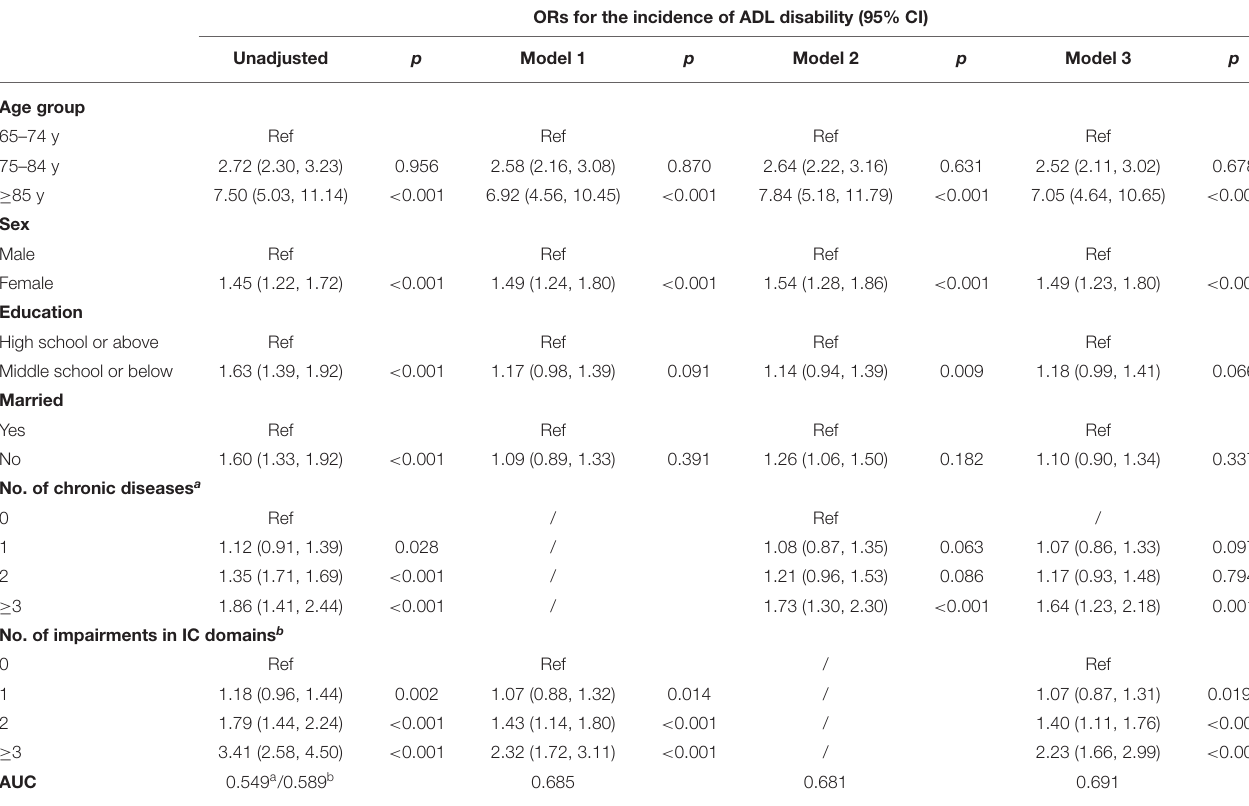
TABLE 4 | Logistic regression to determine the odds of activities of daily living (ADL) disability at 1-year follow-up. ORs for the incidence of ADL disability (95%